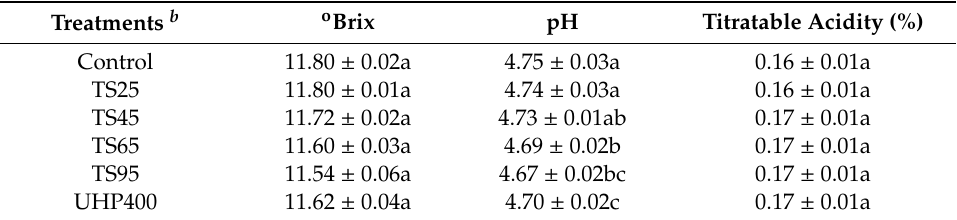
Table 1. E ff ect of di ff erent treatments on Brix, pH, titratable acidity in mango juice a .